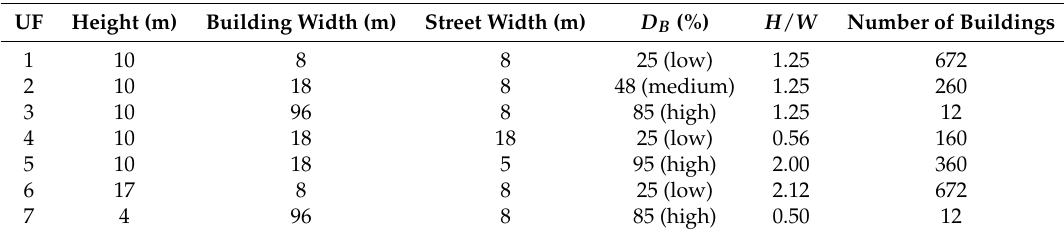
Table 1. Parameters set for each of the seven scenarios